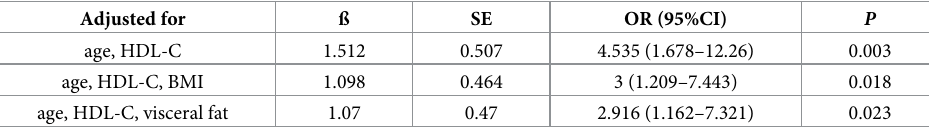
Table 2. Binary logistic regression analysis for the associations of HDL anti-inflammatory capacity with NAFLD. Adjusted for